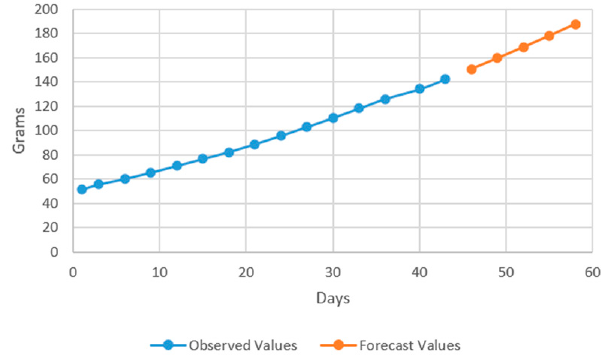
Figure 7. The evolution of Acipenser baerii biomass in A technological scenario.